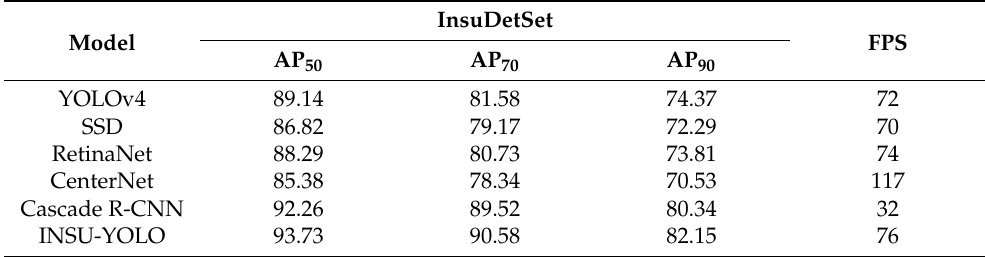
Table 3. APs of the different